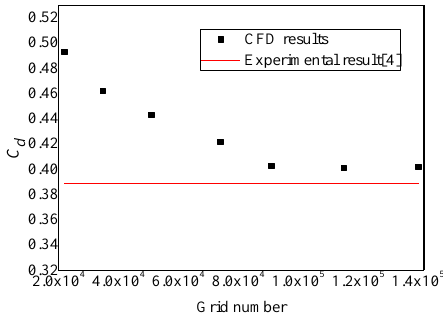
Figure 3. Grid independence test result.